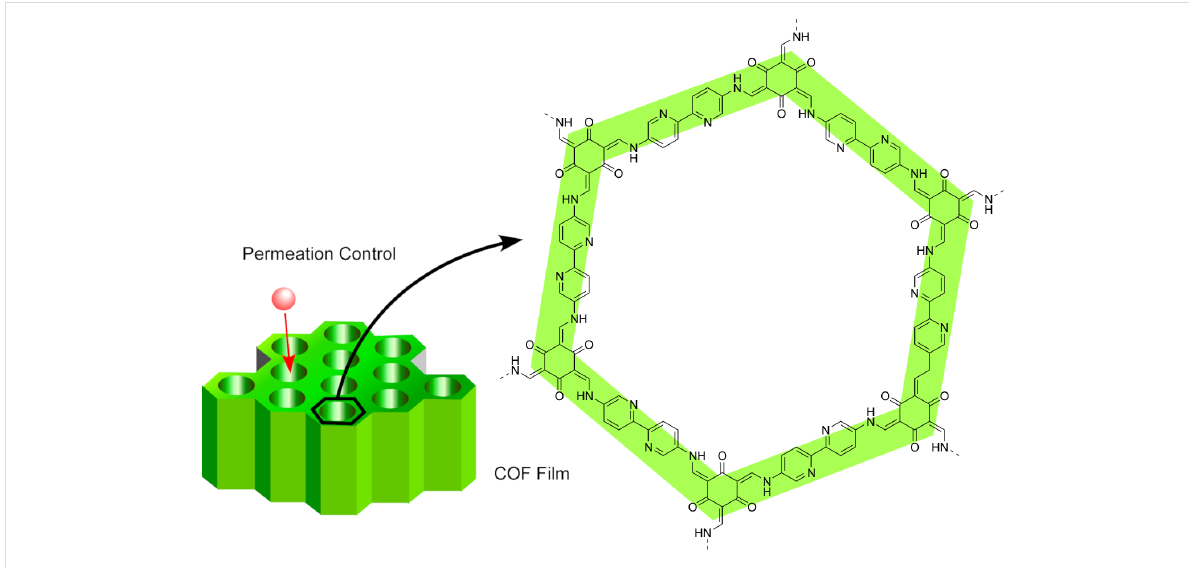
Figure 12: Aqueous solutions of multi-amino-substituted monomers with p -toluene sulfonic acid were layered on a dichloromethane solution contain- ing 1,3,5-triformylphloroglucinol to yield large COF films of sub-100 nm thickness.